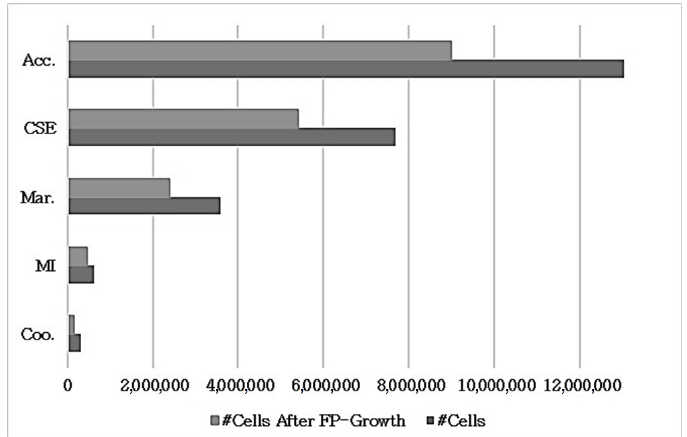
Figure 4. The number of cells in the datasets before and after use of the FP-Growth